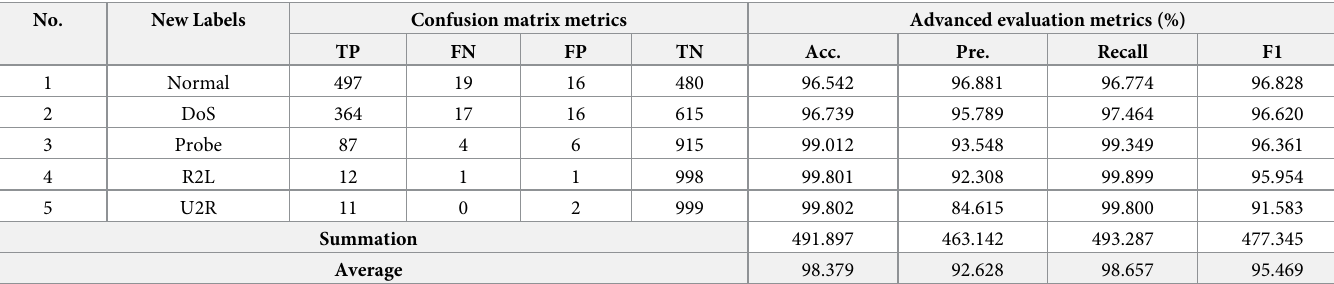
Table 4. NSL-KDD metrics of the above confusion matrix.